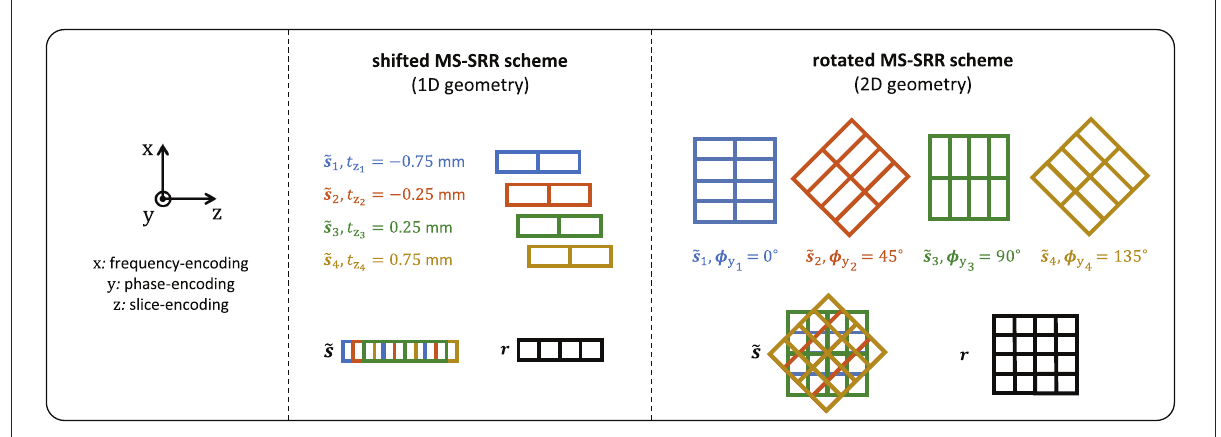
FIGURE1 Acquisition geometries of the MS-SRR shifted and rotated schemes: AF